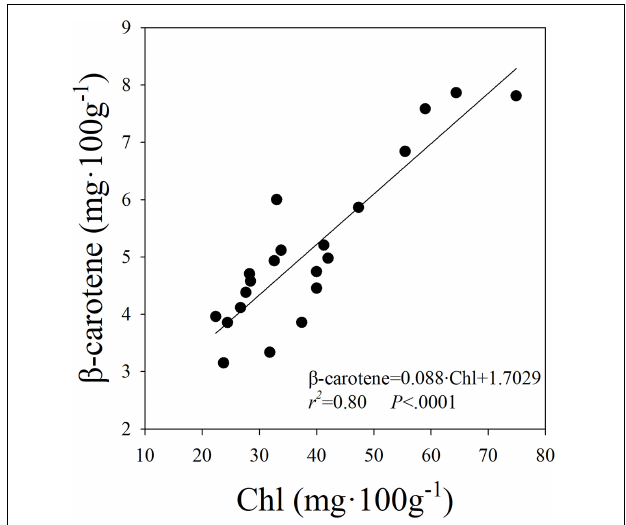
FIGURE 6 | Linear relationship between the levels of beta-carotene ( β -carotene) and chlorophylls (Chl) in romaine lettuce. A linear regression was fitted to data from three treatments and all seven replications from two experiments.